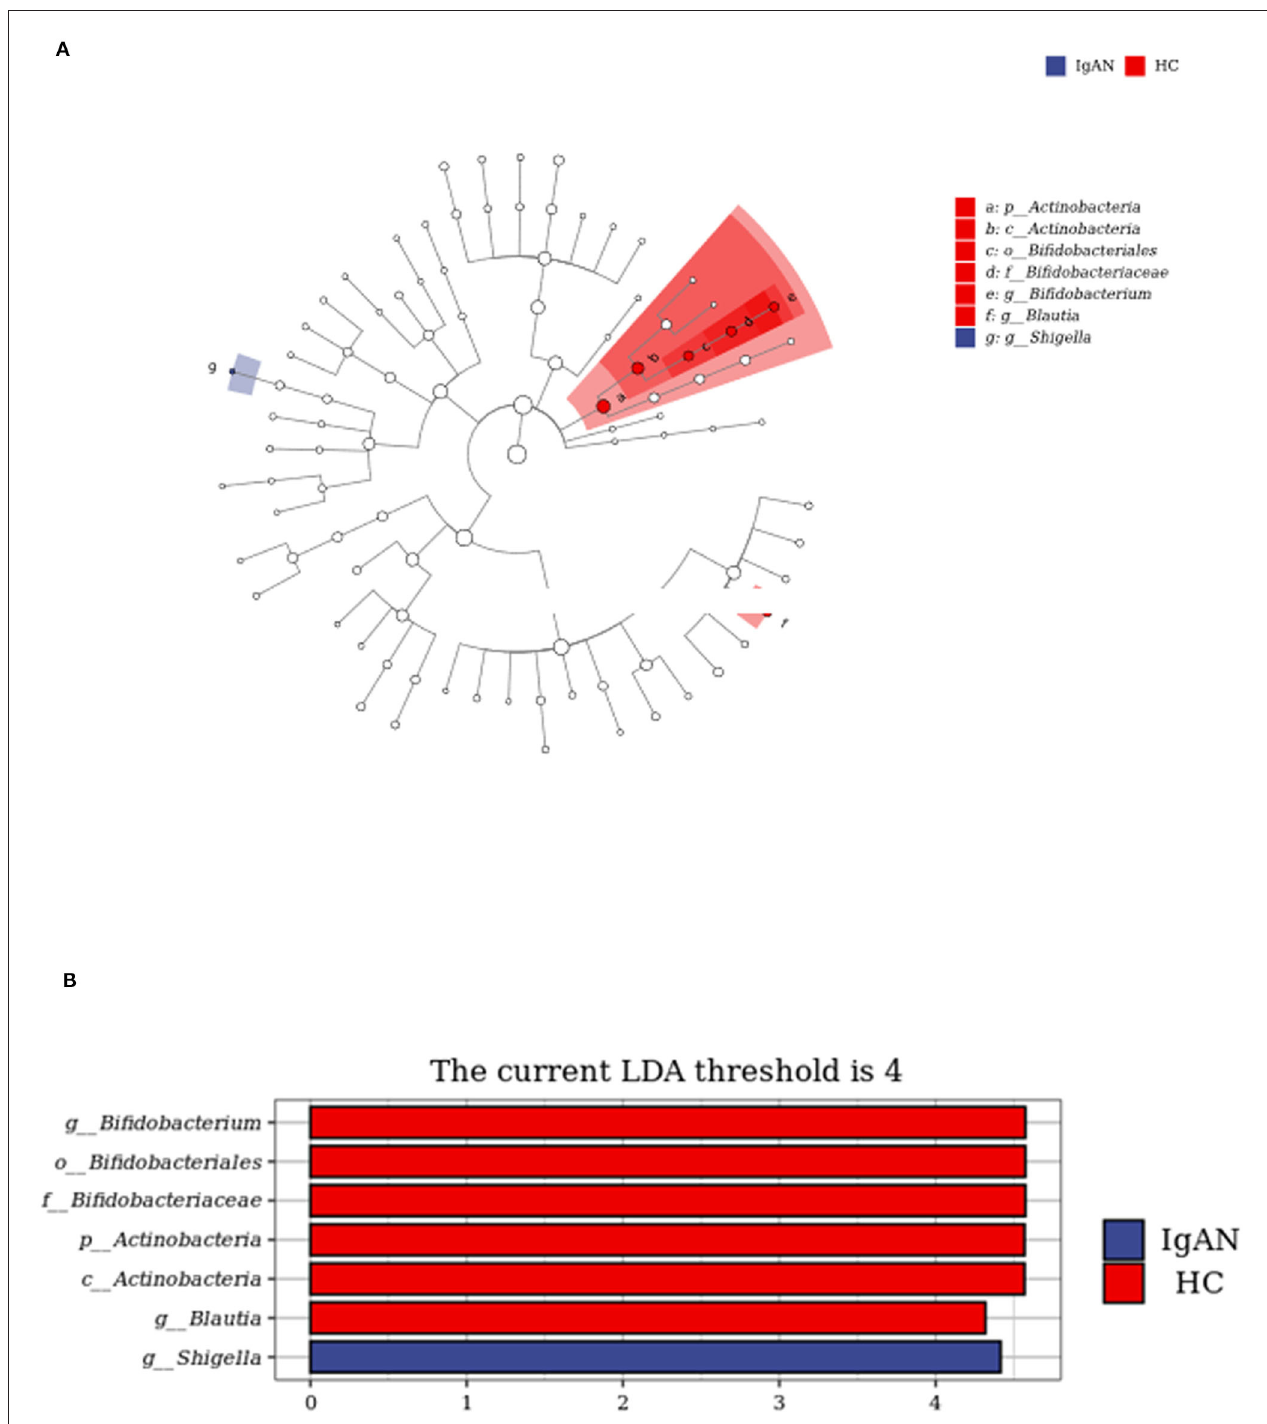
FIGURE 4 | LEfSe analysis to identify biomarkers of IgAN. (A) Cladogram of LEfSe analysis. (B) Histogram of LEfSe analysis.